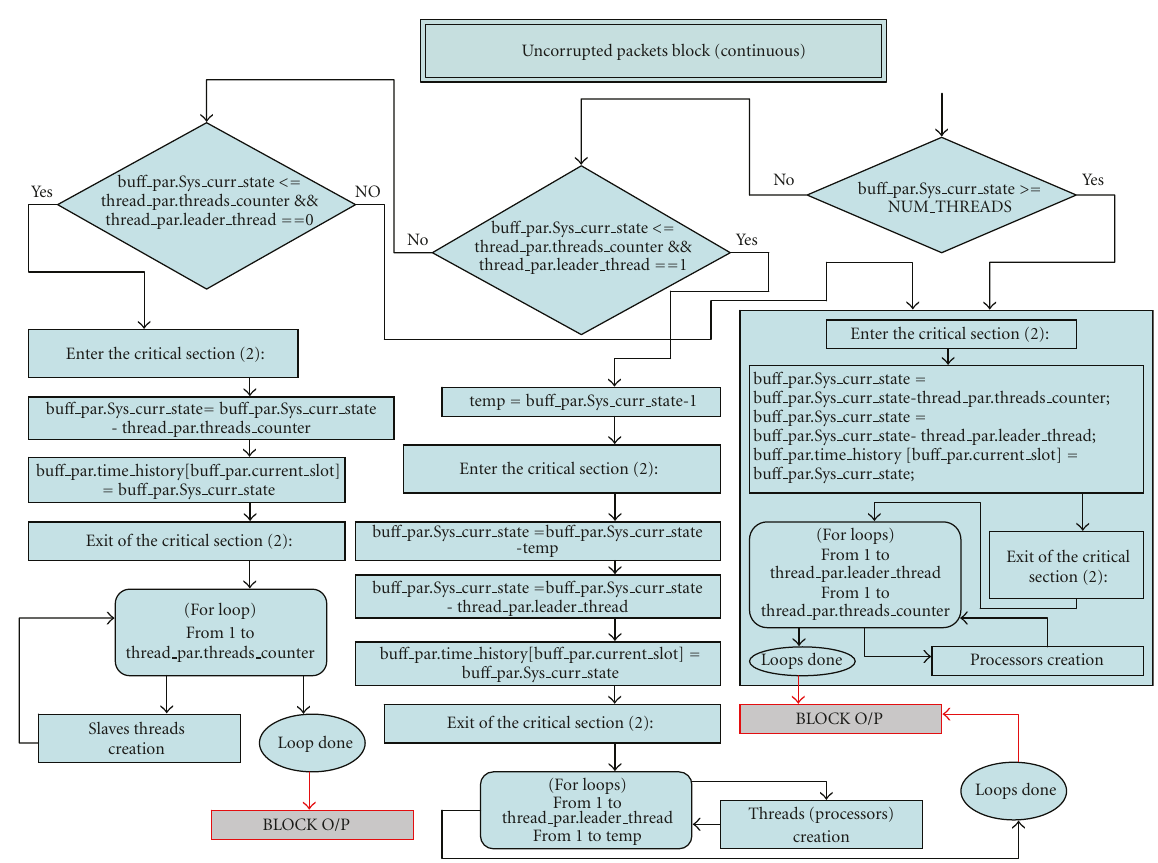
Figure 14: Major steps of uncorrupted packets block simulation (extension for Figure